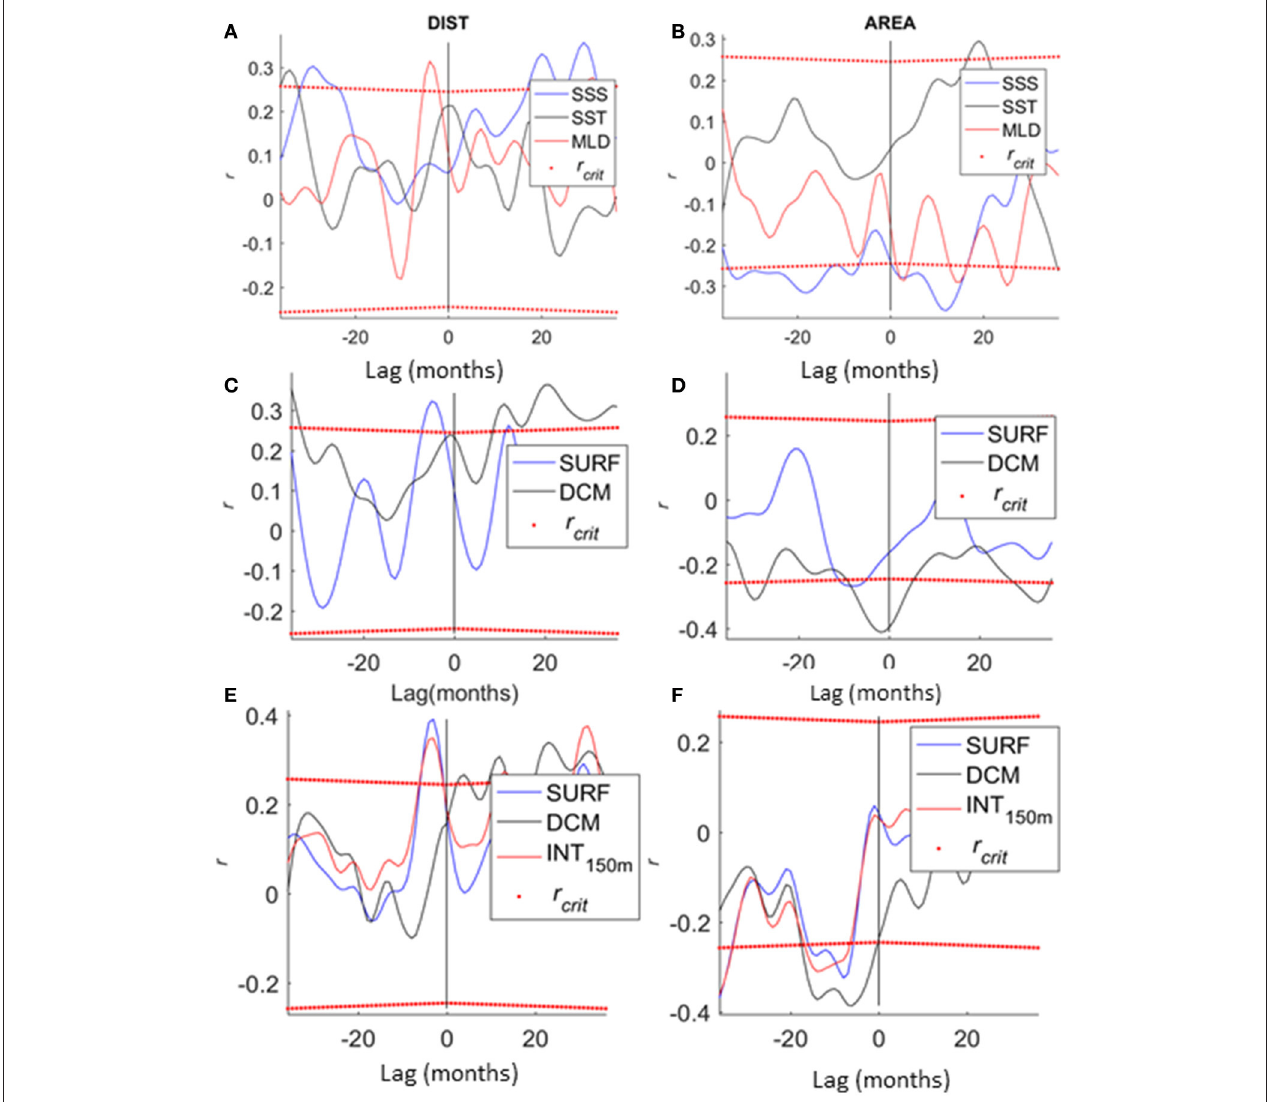
FIGURE 8 | Correlation between in situ biophysical variables at Station ALOHA and isolation of Station ALOHA (DIST) and expansion of subtropical seascape (AREA). (A,B) SST, mixed layer depth, and salinity; (C,D) Tchl a in the surface and DCM; (E,F) NPP in surface, DCM, and integrated over the upper 150m. Geographic metrics lead biophysical variables when lag is